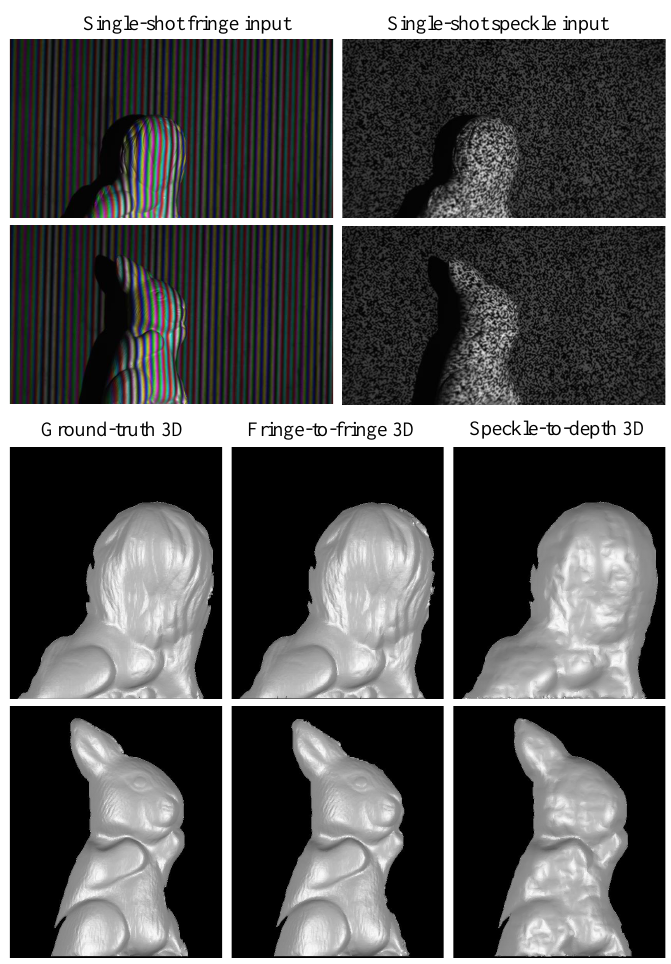
Figure 5. 3D shape reconstruction of the proposed technique and the comparative speckle-to- depth